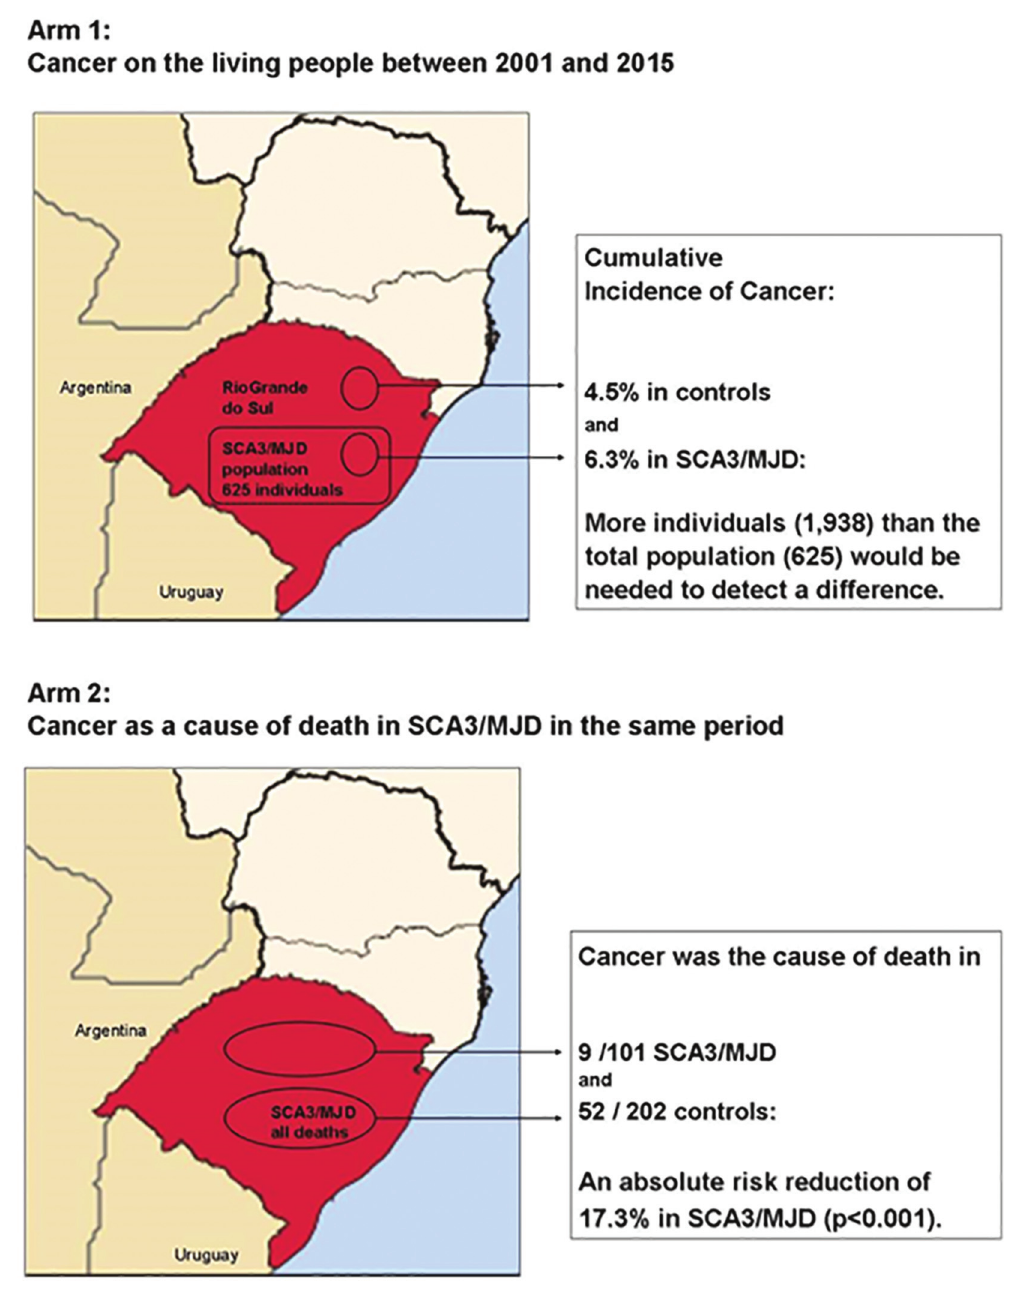
Figure 2 - Cancer in SCA3/MJD versus general population of Rio Grande do Sul state,